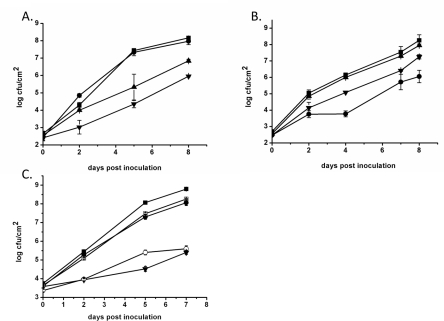
Strain 85-10ΔacnB shows restricted growth in planta.The indicated strains were grown as follows: A. Growth in planta where filled squares represent strain 85-10, filled circles represent strain 85-10ΔacnA, filled triangles represent strain 85-10ΔacnB and filled inverted triangles represent strain 85*ΔhrcN B. Growth in planta where filled squares represent strain 85-10, filled triangles represent strain 85-10ΔXCV1925-26, filled inverted triangles represent strain 85-10ΔXCV1925-26acnB and filled circles represent strain 85*ΔhrcN; C. Growth in planta where filled squares represent strain 85-10, open squares represent strain 85-10/pLAFR6, filled circles represent strain 85-10ΔacnB/pL6acnB, open circles represent strain 85-10ΔacnB/pLAFR6 and filled inverted triangles represent 85*ΔhrcN. The standard error is shown for each experiment.